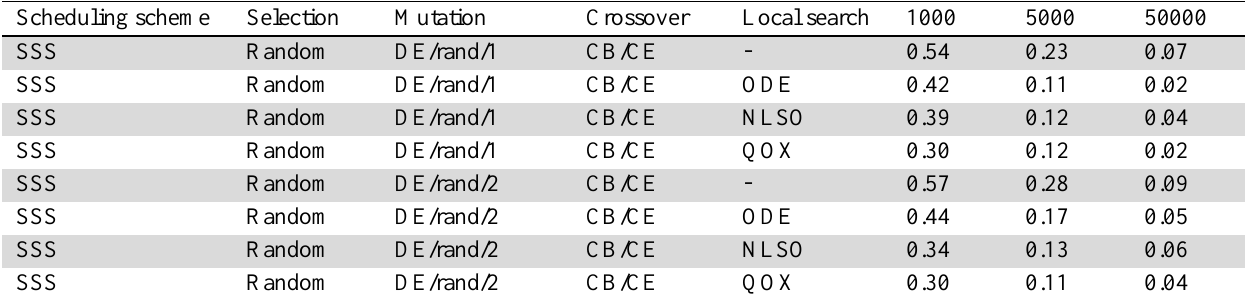
Effect of schedule generation scheme, mutation operators, and selection method on average deviation Scheduling